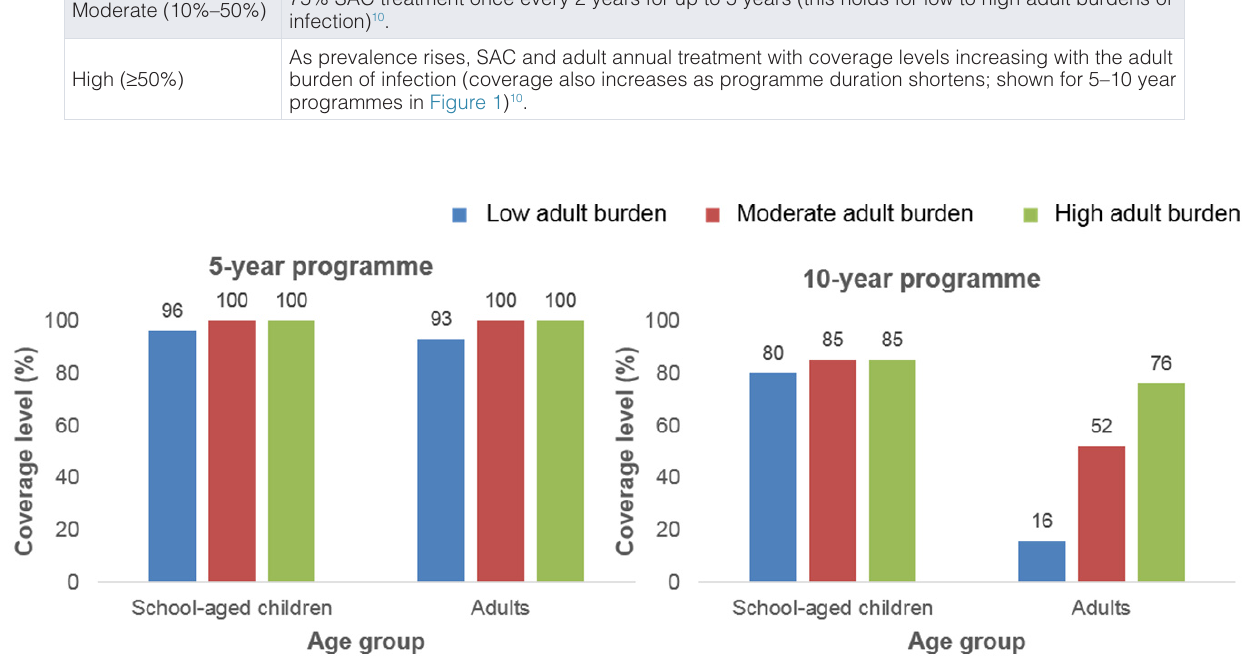
Figure 1. Coverage levels required to reach the WHO goal of elimination as a public health problem (EPHP) in a high prevalence setting ( ≥ 50% SAC baseline prevalence) within 5- and 10-year annual treatment programmes (assuming random coverage and no non-adherence). School-aged children (SAC) are 5–14 years old and adults are 15+ years old. This figure has been reproduced from 10 under a Creative Commons Attribution 4.0 International (CC BY 4.0)